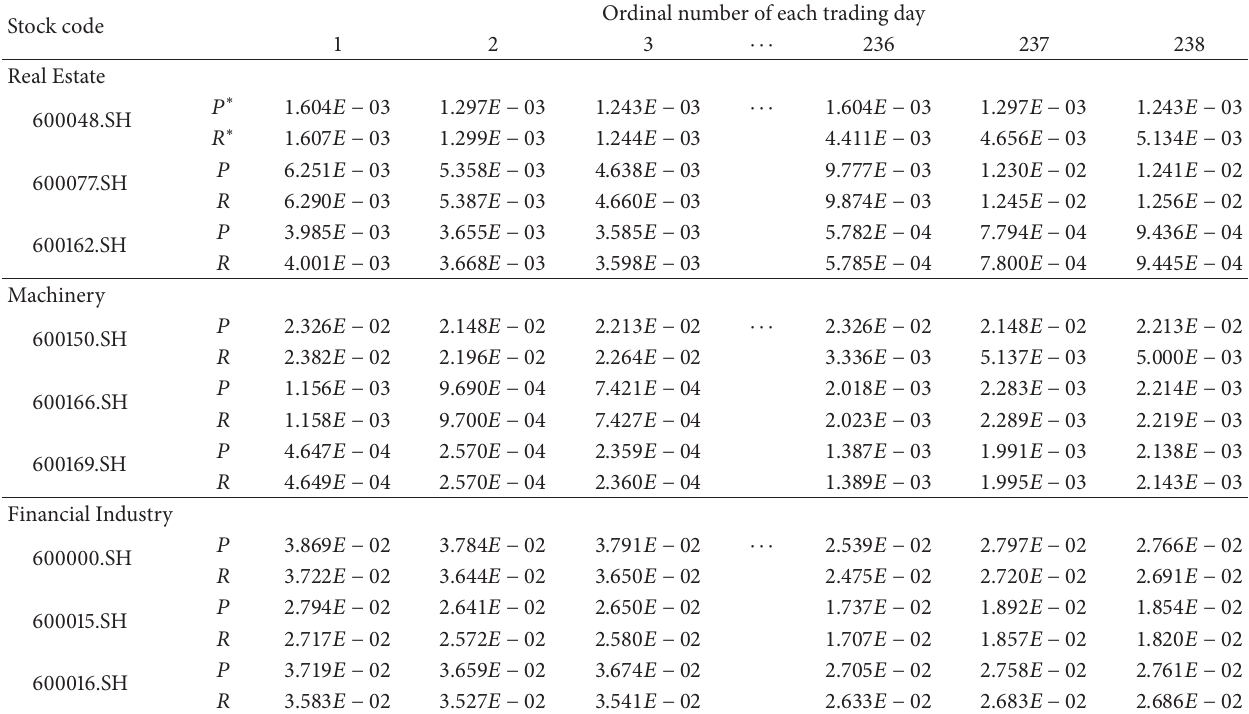
Table 1: Dynamic default probabilities and Poisson intensity.